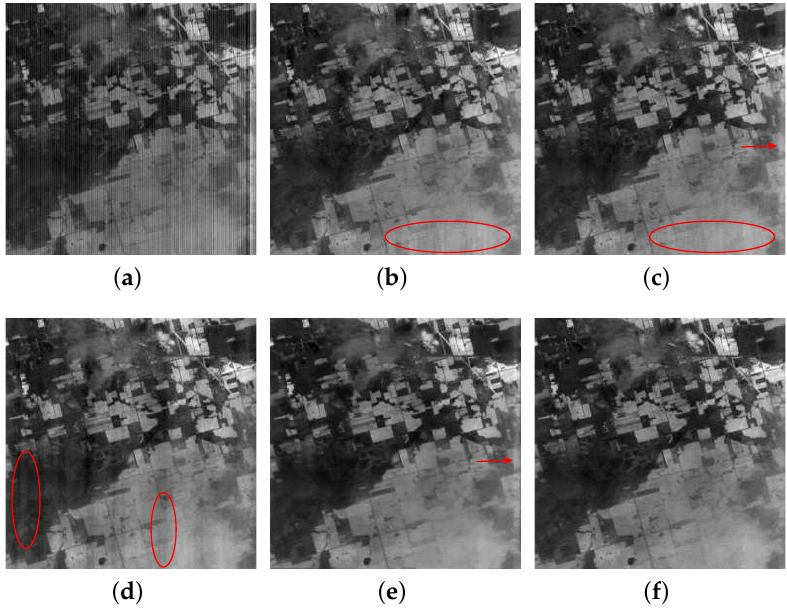
Figure 9. Destriping results of nonperiodic stripes in Hyperion band 211. ( a ) Original image; ( b ) WAFT; ( c ) SLD; ( d ) GSLV; ( e ) LRSID; ( f ) the proposed method. (2) Periodic stripes: Figures 11–13 present the destriping results for the three periodic